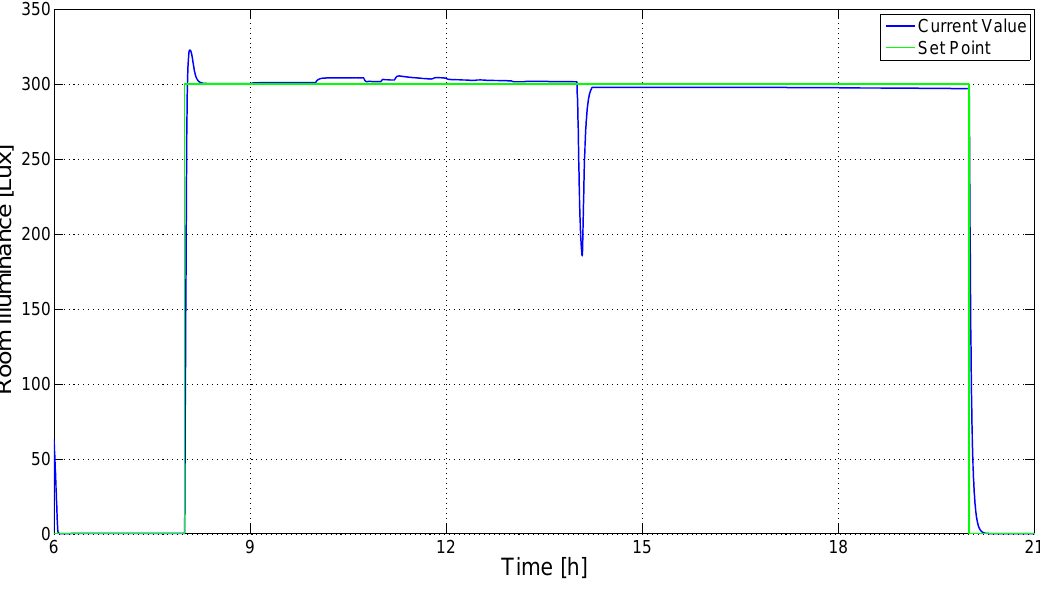
Figure 40. Control results (third scenario, modified control system, Energy Saving policy): room illuminance (CV).